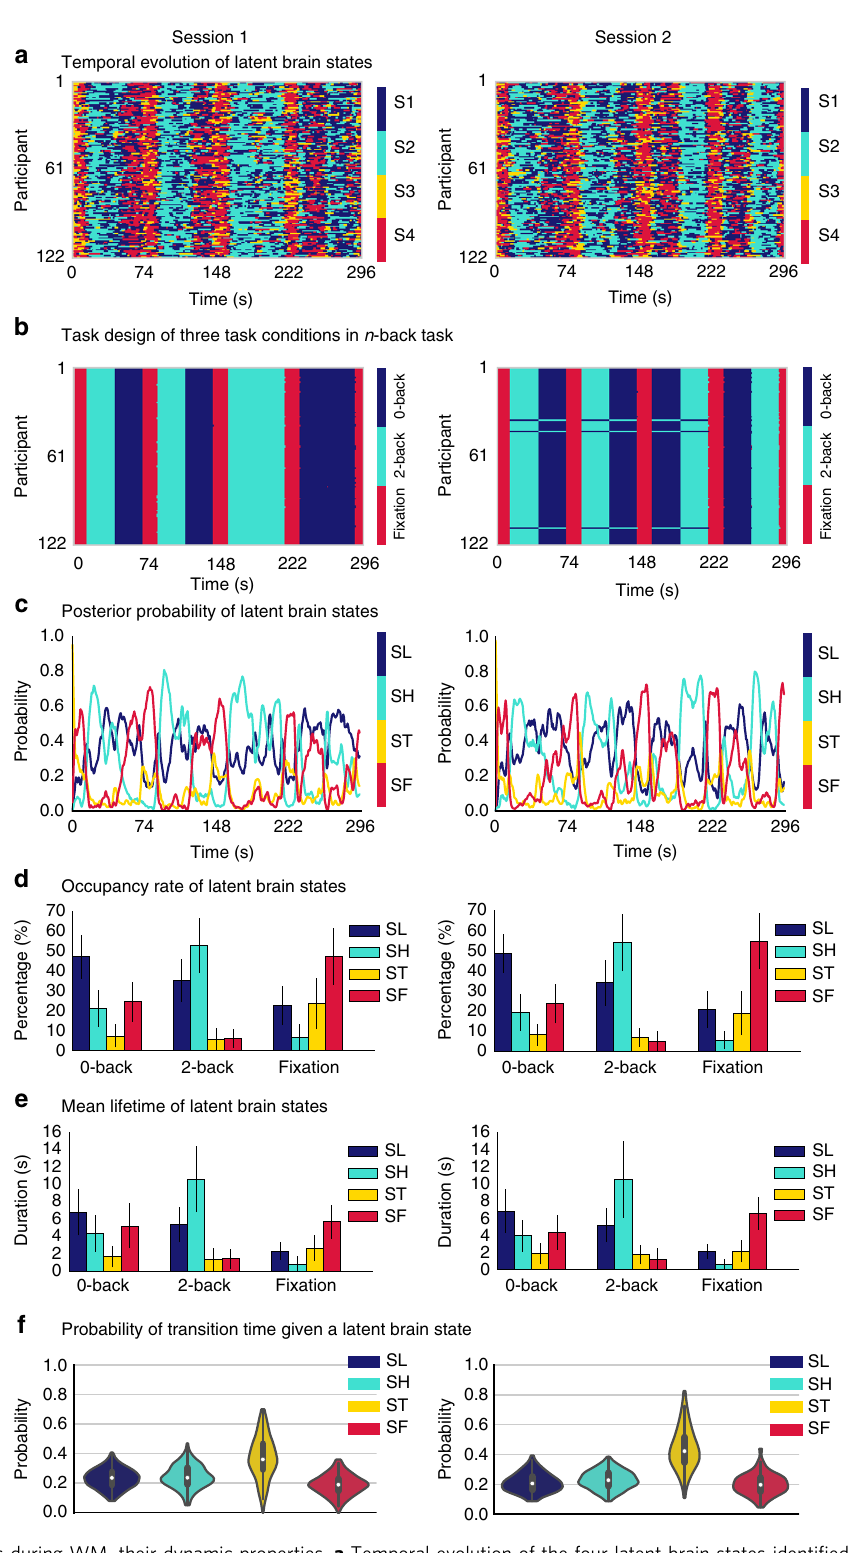
Fig. 4 Latent brain states during WM, their dynamic properties. a Temporal evolution of the four latent brain states identi fi ed in each of the 122 participants. b Corresponding task waveforms of the three task conditions in the n -back WM task — 0-back, 2-back, and fi xation blocks — are shown in the same layout. c Time-varying posterior probability of each latent brain state across participants. d Occupancy rates of latent brain states for the three states which dominate the 0-back, 2-back, and fi xation task blocks, SL, SH, and SF respectively ( p s < 0.001, two-tailed t -test). e Mean lifetimes of latent brain states for the three states which dominate the 0-back, 2-back, and fi xation task blocks, SL, SH, and SF respectively ( p s < 0.001, two-tailed t -test). f BSDS revealed a novel transition state ST, which occurs more frequently right after the onset of experimental task blocks ( p s < 0.001, two-tailed t -test). Note that SL, SH, ST, and SF were named by their task dominancy in c – f , which correspond to S1, S2, S3, S4 in a . Error bar stands for standard deviation. Color